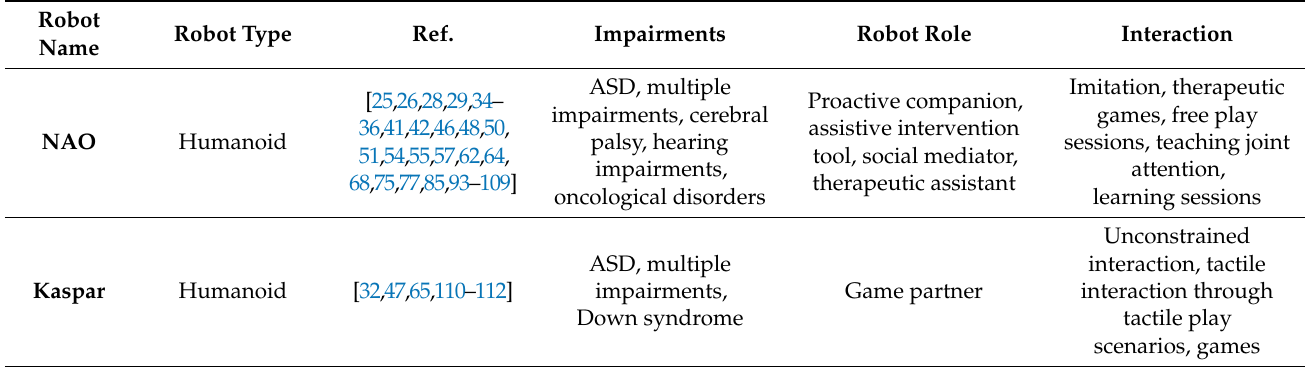
Table 7. Main characteristics of the commonly used social robots.